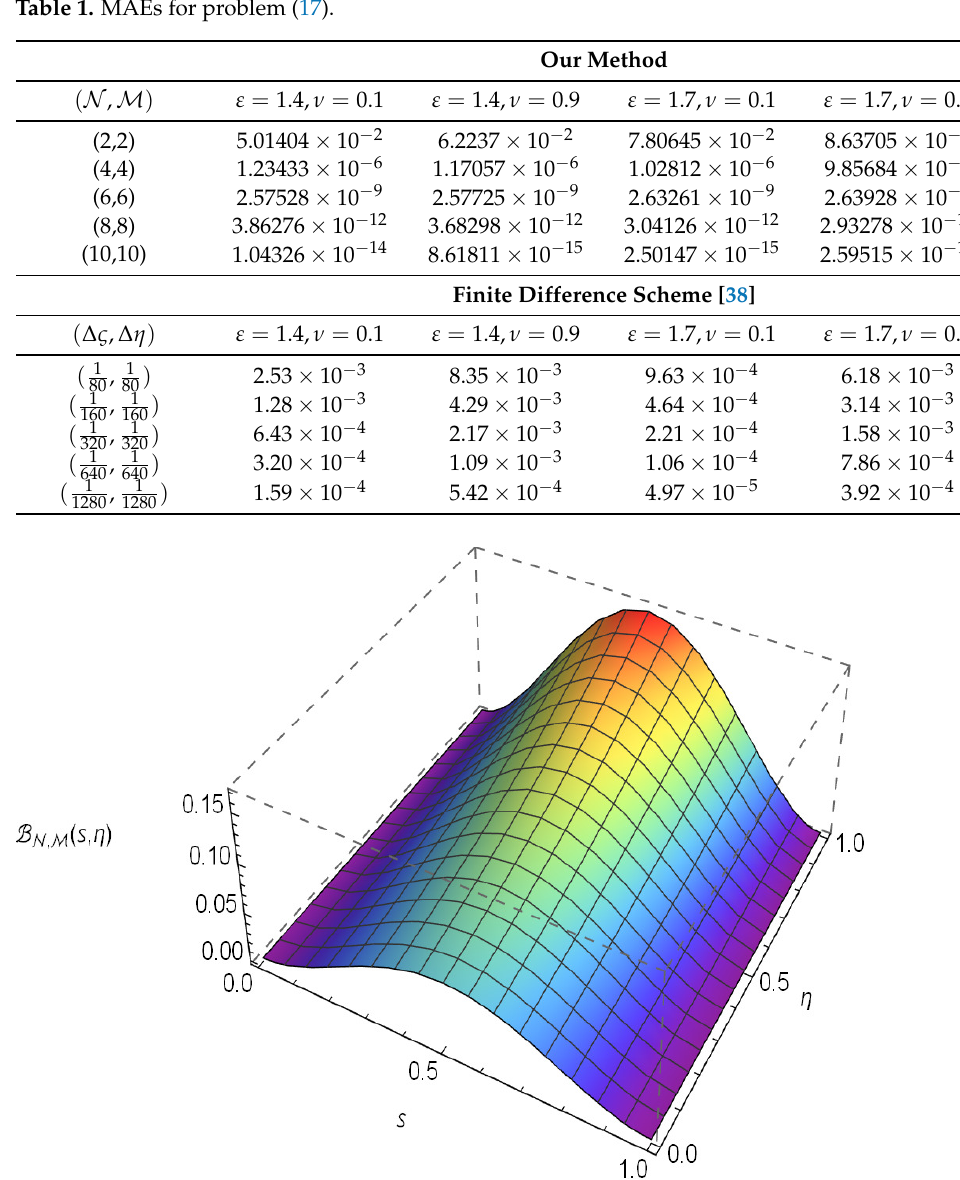
Figure 1. Numerical solution of the problem (17), where ε = 1.4, ν = 0.1 and N = M =